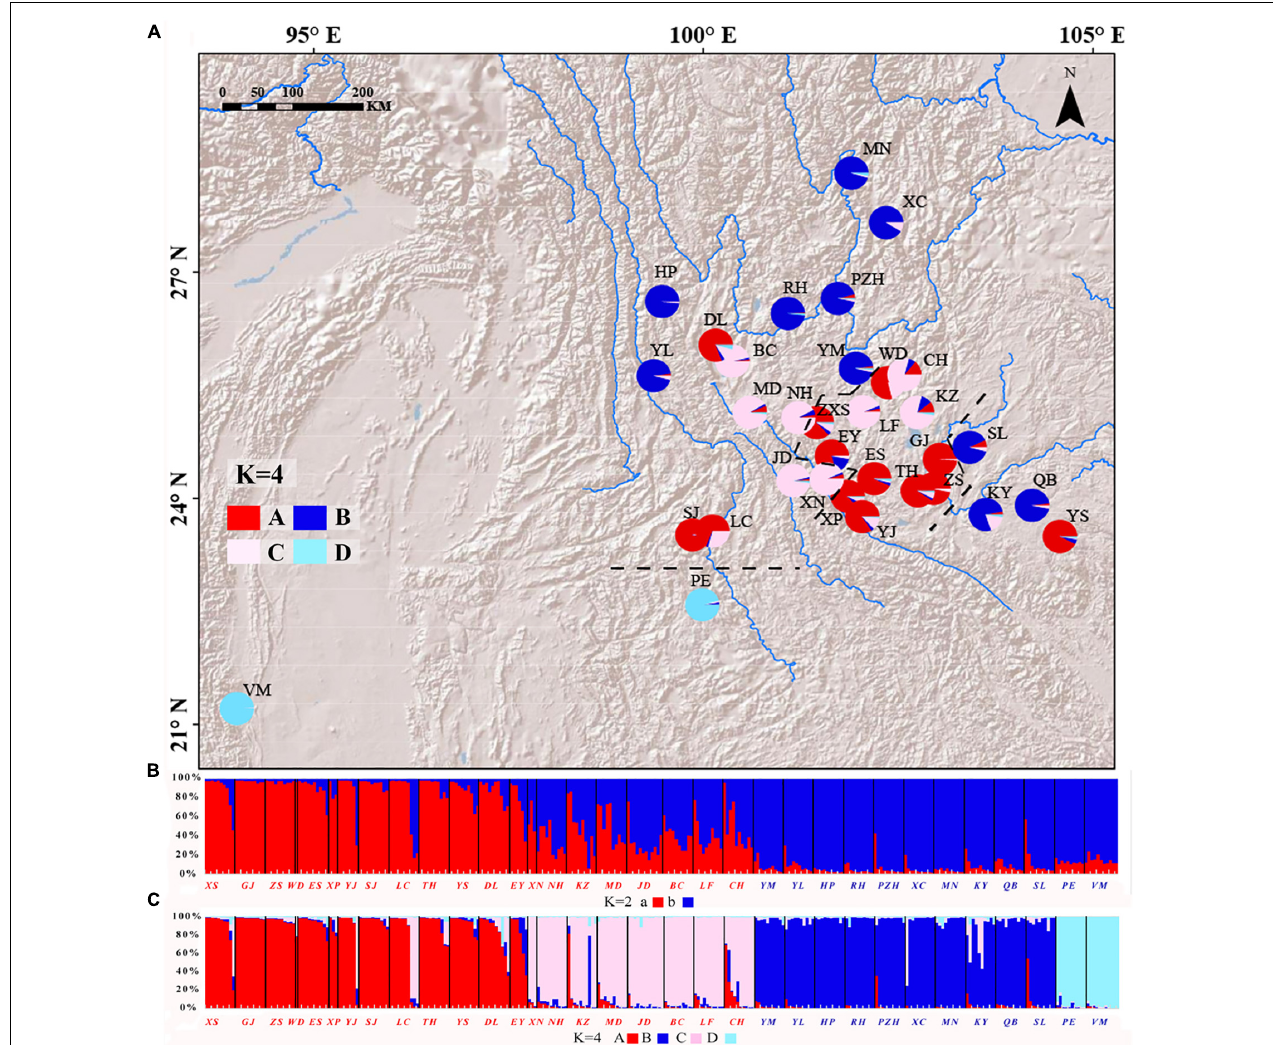
FIGURE 4 | (A) Geographic distribution of the Quercus franchetii complex according to STRUCTURE grouping analyses. STRUCTURE cluster analysis diagram when (B) K = 2 and (C) K = 4. The colors in the pie charts represent different groupings, and the black dotted line indicates the inferred geographic isolation based on